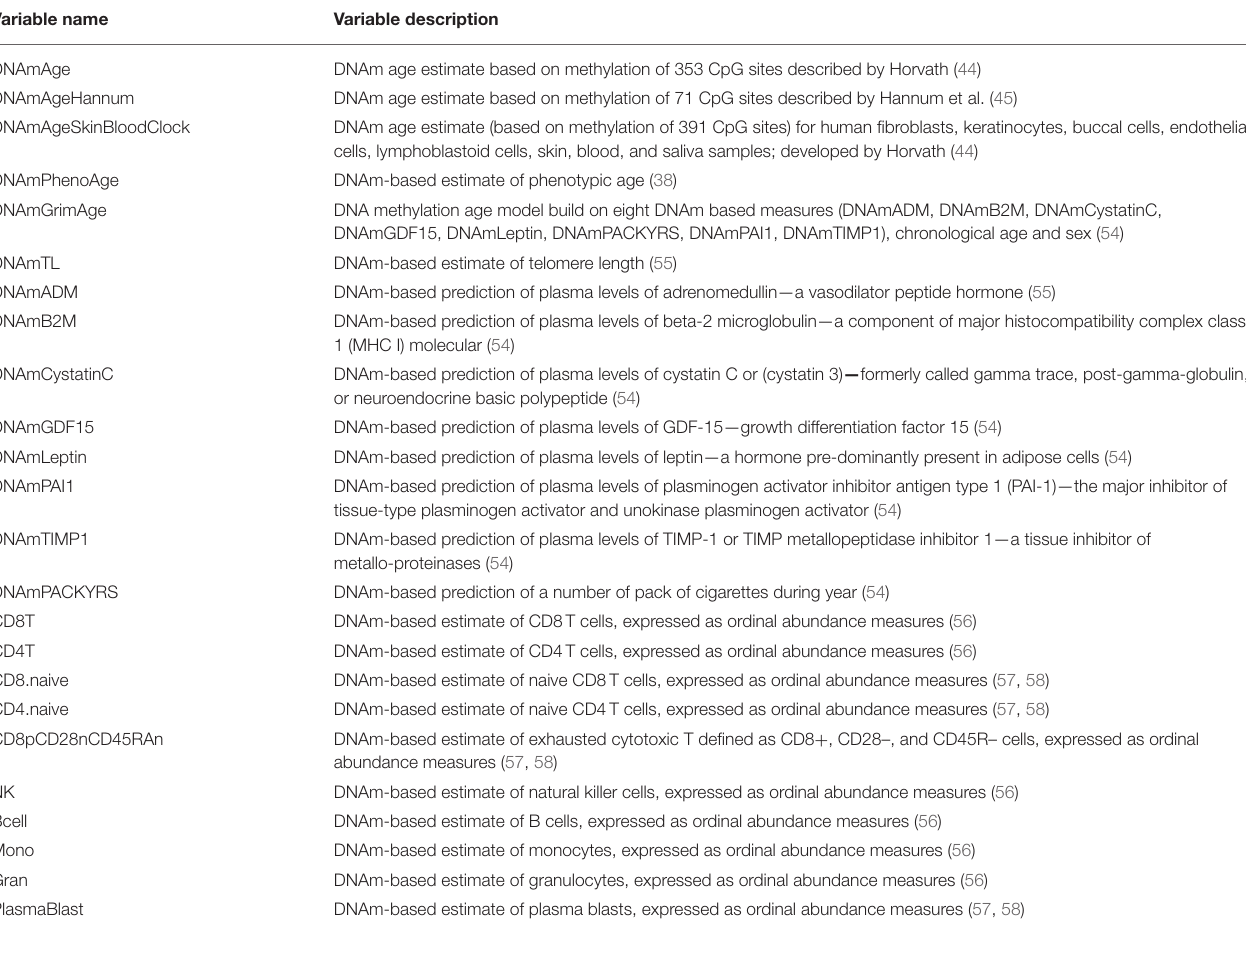
TABLE 1 | List of variables calculated by the new DNA methylation age calculator available online at https://dnamage.genetics.ucla.edu/. Variable